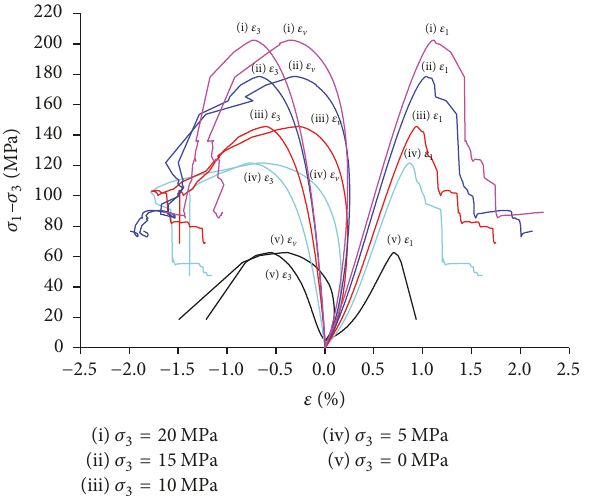
Figure 3: Stress-strain curves of rock samples under unloading confining pressure.